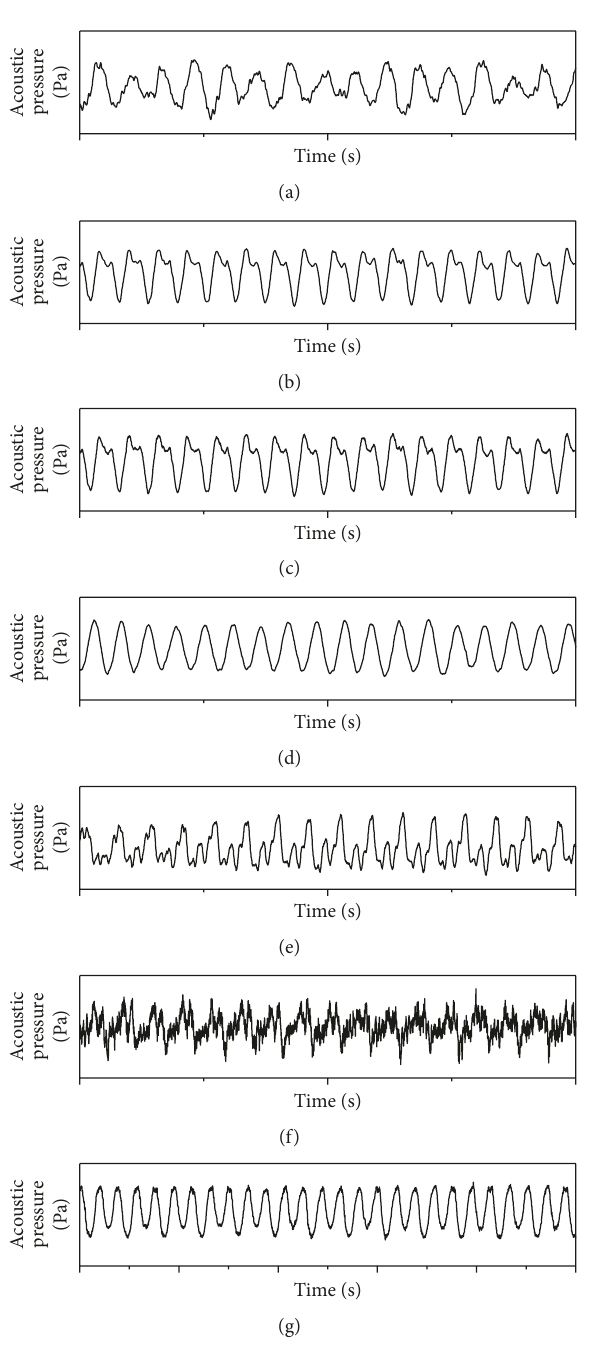
Figure 7: Acoustic pressure profiles of stimuli used in the auditory experiment. The sounds from (a) to (c) are the synthesized sounds and the sounds from (d) to (g) are the measured sounds. The 𝑥 -axis of each layer indicates time in seconds of 0–0.5, respectively.